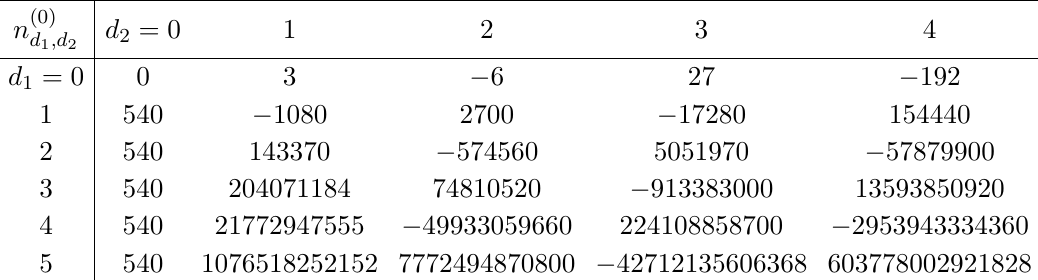
Table 15 . Genus zero Gopakumar-Vafa invariants at low degrees for X (1)